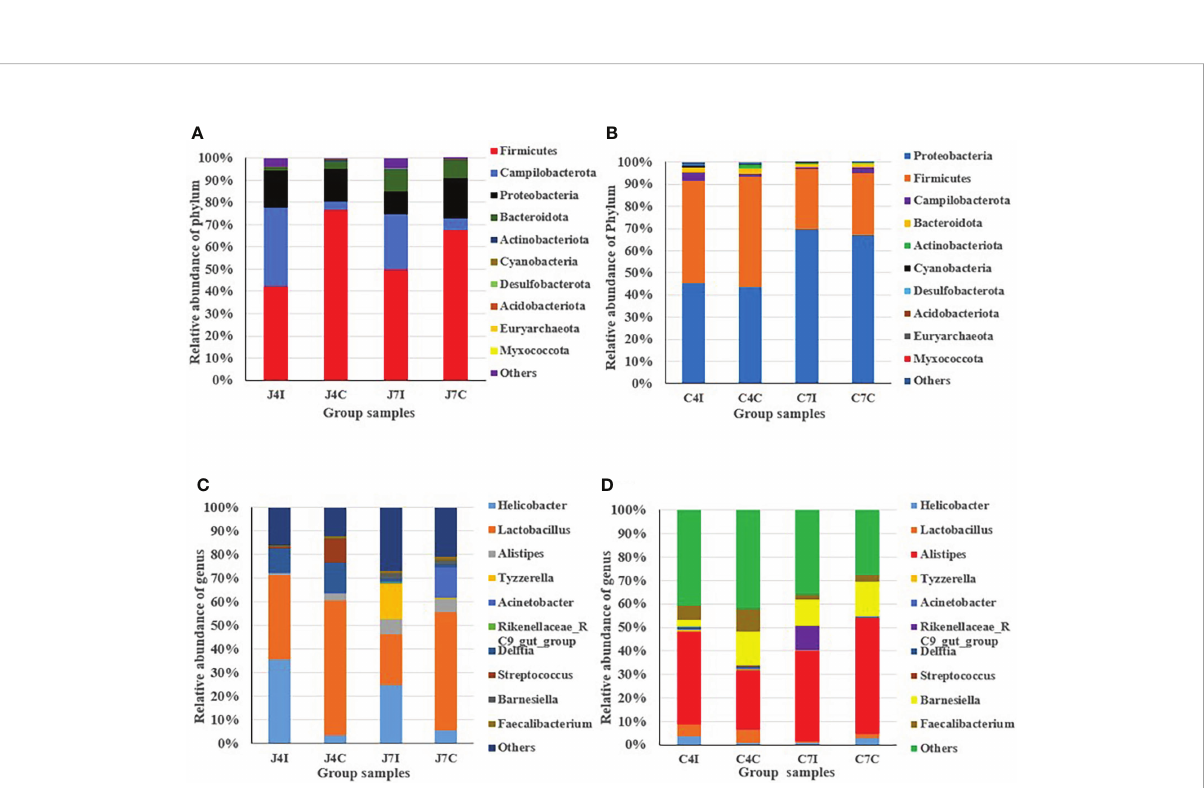
FIGURE 2 Distribution and relative abundance of the most common microbial phyla and genus in different types of samples. (A) Phyla - jejunum. (B) Phyla – cecum. (C) Genus - jejunum. (D) Genus -